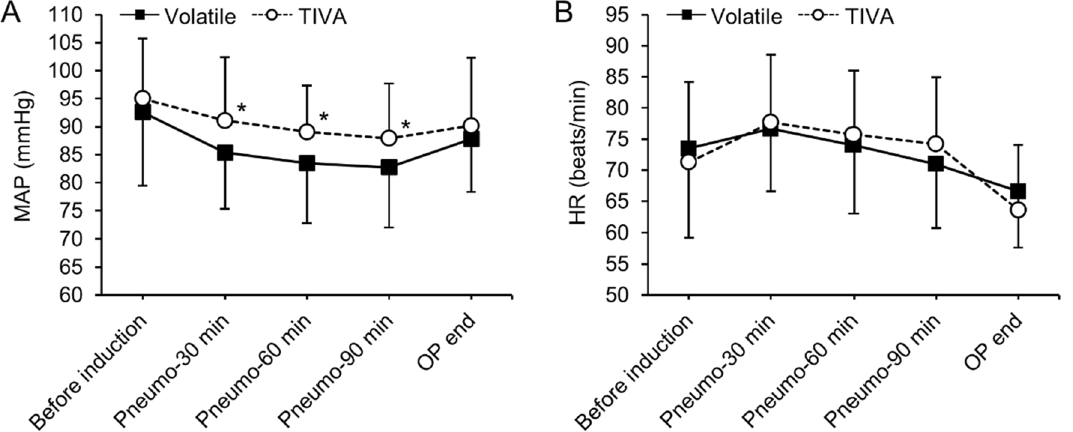
Figure 2. Intraoperative changes in ( A ) mean arterial pressure (MAP) and ( B ) heart rate (HR). Pneumo, pneumoperitoneum; OP, operation; TIVA, total intravenous anesthesia. Values are expressed as mean ± SD. *Bonferroni-corrected P < 0.05 versus Volatile